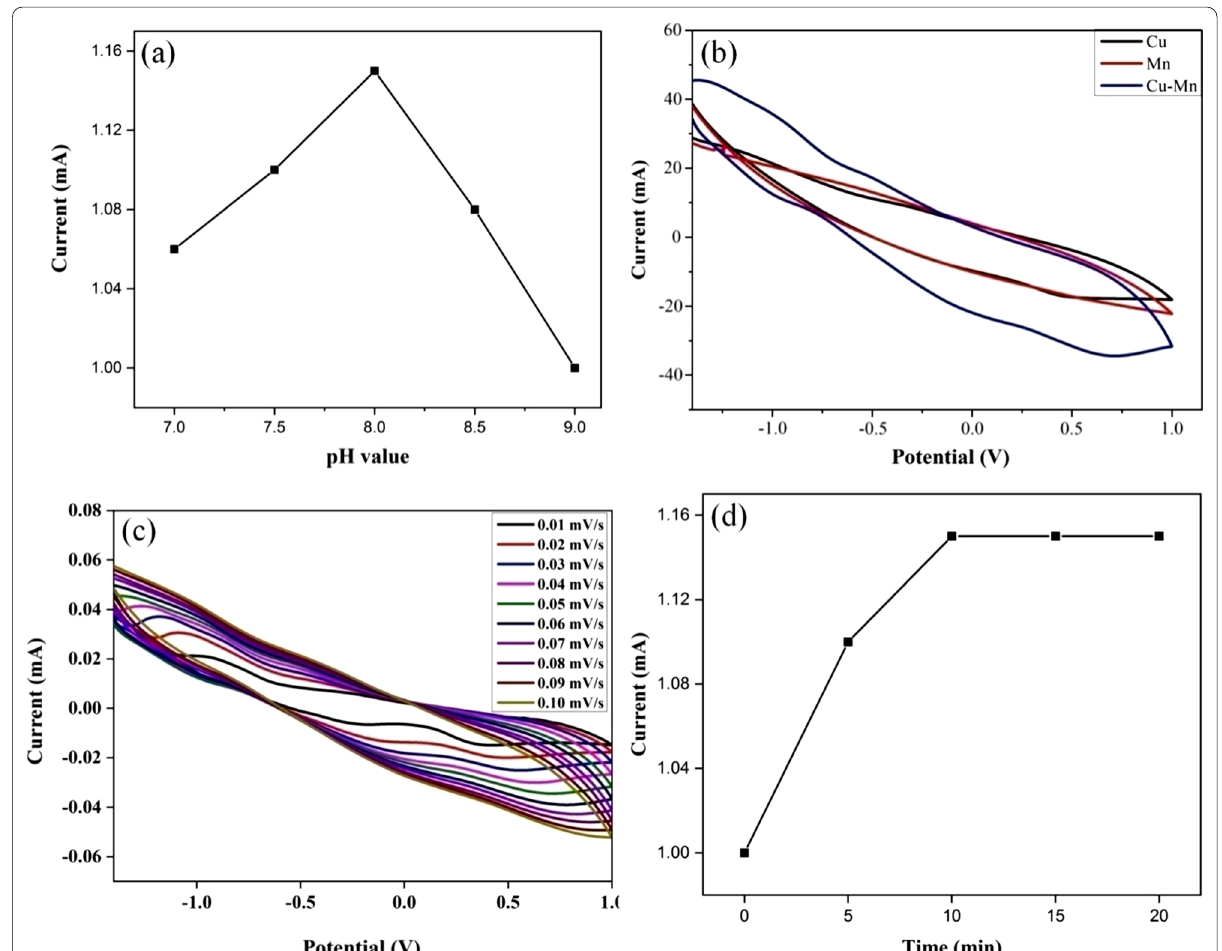
Fig. 5 a Cotton/ppy/Cu/Cu–Mn modified electrode study in presence of different pH values, b CV of Cu, Mn and Cu–Mn deposited on cotton/ ppy/Cu fabric, c effect of scan rate on cotton/ppy/Cu/Cu–Mn modified electrode and d incubation time study of cotton/ppy/Cu/Cu–Mn modified electrode in PBS containing 100 µM of